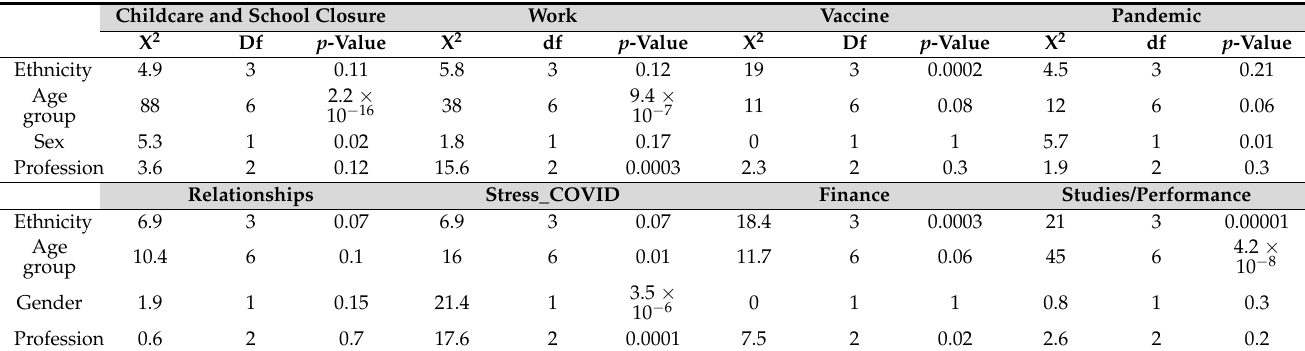
Table 3. Statistical significance of relationships between major causes of mental stress reported in the dataset and sociodemographic